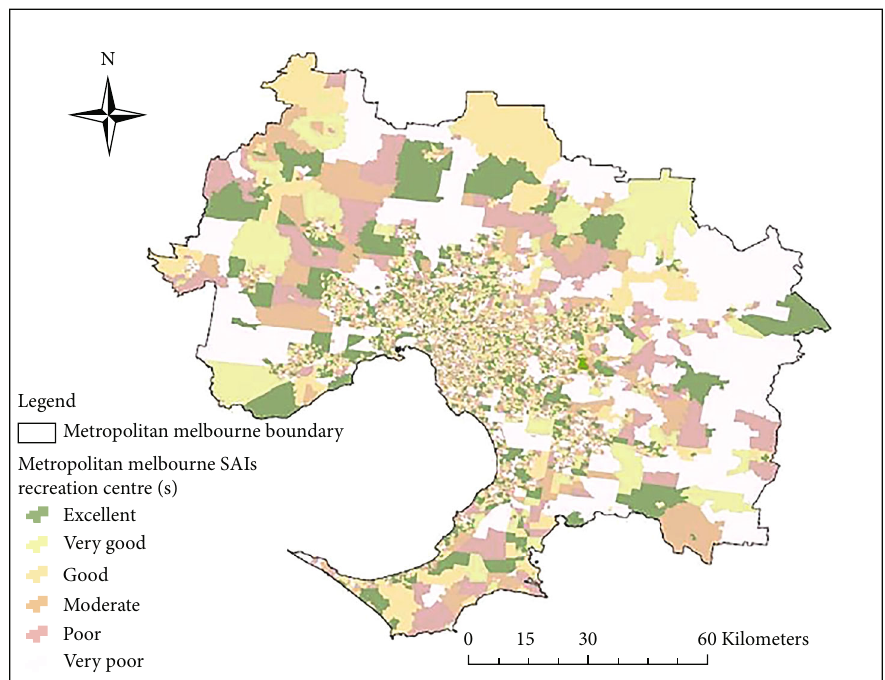
Figure 5: Older people public transport accessibility index for education centre(s) (https://desktop.arcgis.com/en/arcmap/latest) [67].